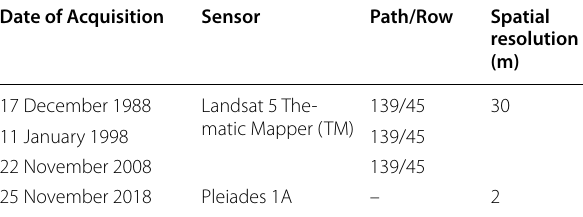
Table 1 Details of satellite imageries used for LULC